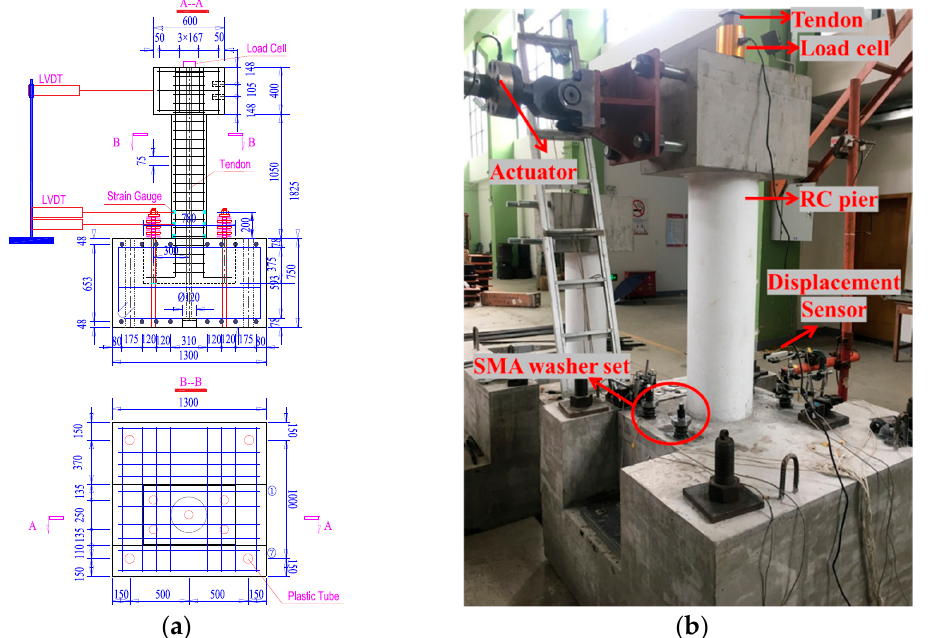
Figure 2. Test of the SCR pier: ( a ) drawing of the SCR pier specimen, ( b ) photo of the test setup.